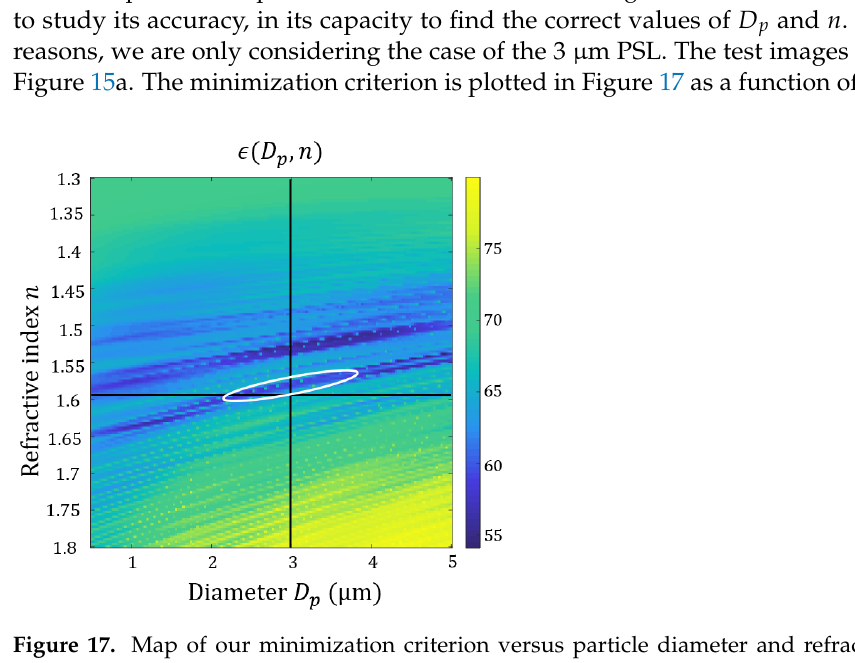
Figure 17. Map of our minimization criterion versus particle diameter and refractive index in logarithmic scale.